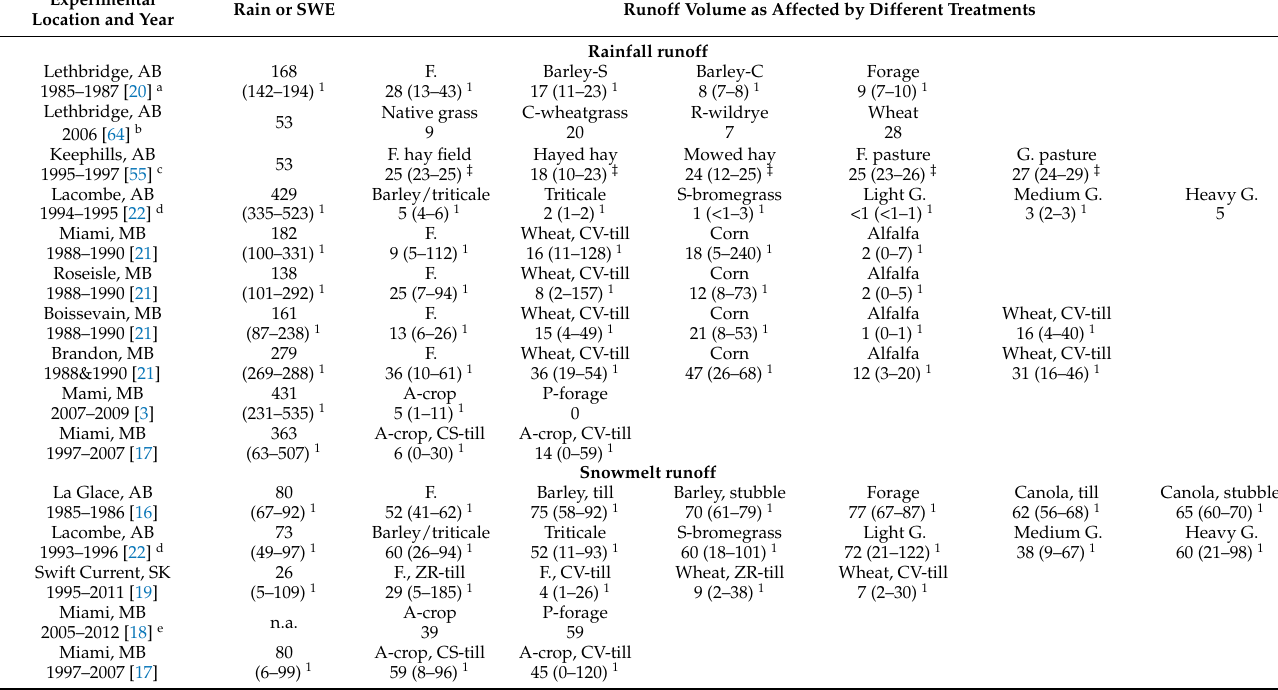
a Simulated rainfall. Barley-S: barley sown in rows parallel to the slope; and Barley-C: sown perpendicular to the slope. b Simulated rainfall. The experiment was conducted at one site-year. c Simulated rainfall. Three sites for each of the hay treatments and two sites for each of the pasture treatments. d Each value for a crop is an average of three grazing treatments; and each value for a grazing treatment is an average of four crops. e Each value is an average of multiple years. 1 The range shows difference between years. ‡ The range shows the difference between